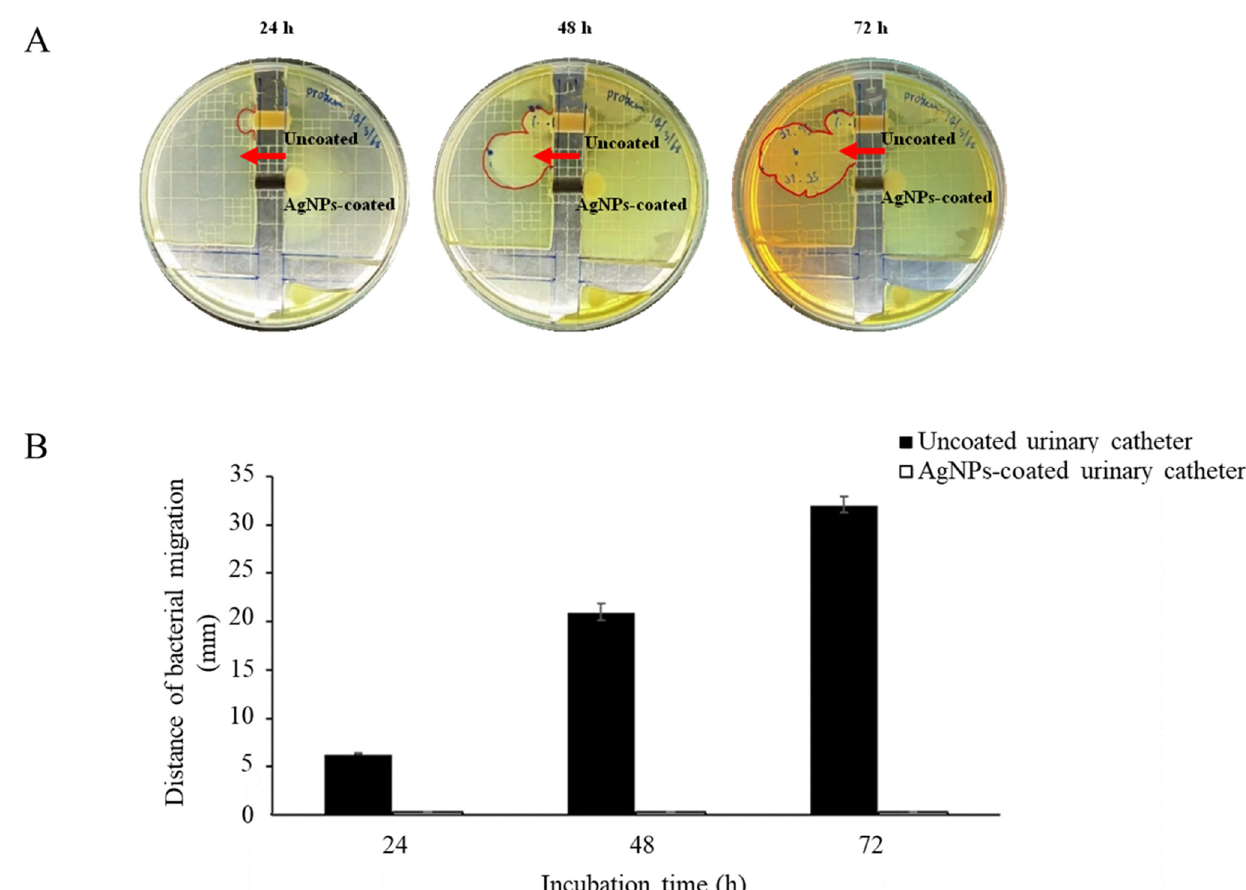
Figure 6. ( A ) Catheter bridge model of Proteus mirabilis migrating over 1 cm sections of uncoated and AgNPs-coated urinary catheter after 24, 48, and 72 h. The arrow demonstrates bacterial migration from the right to left side. ( B ) The distance of the bacterial migration values. The values indicate mean ± SD from three independent experiments performed in triplicate, p < 0.05. A representative photograph was from one of the three independent examinations.